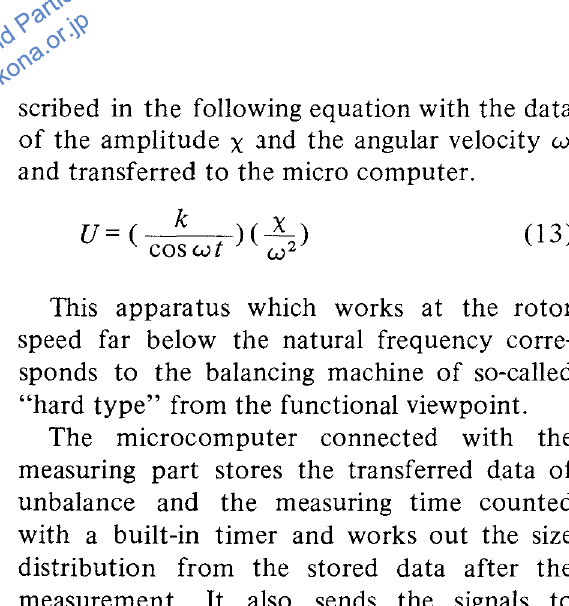
Fig. 4 Size distributions measured by different methods